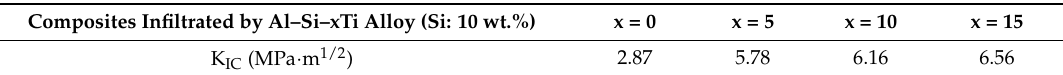
Figure 5. Bending strength and fracture toughness (determined using the single-edge notched beam (SENB) test) of the composites infiltrated by the Al–Si–xTi alloy (Si: 10 wt.%). Table 4. Fracture toughness values of the composites infiltrated by the Al–Si–xTi alloy (Si: 10 wt.%), measured using the Vickers indentation